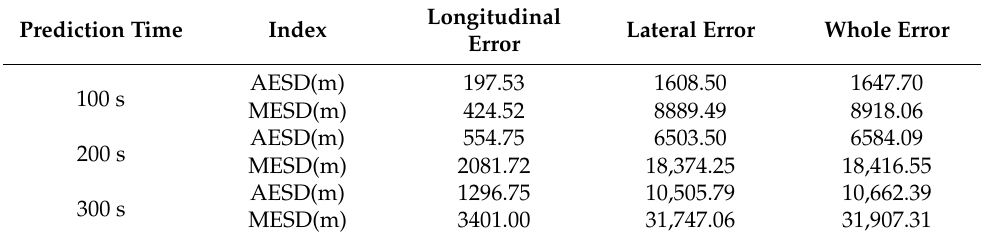
Table 1. Prediction effect within different prediction times.